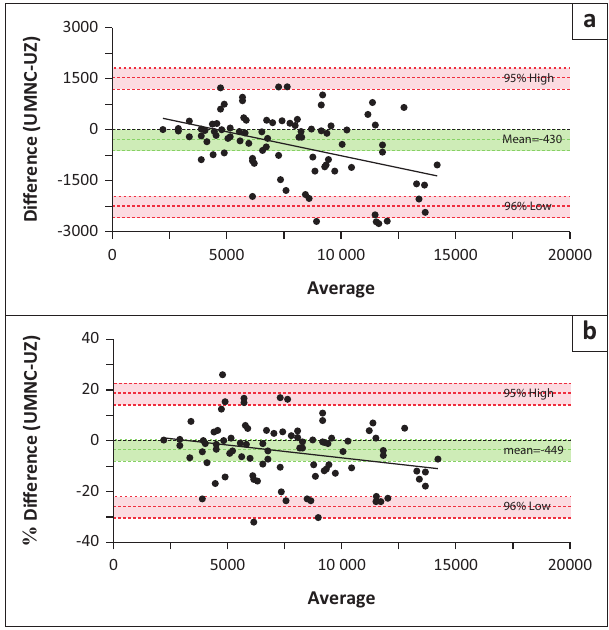
FIGURE 1: Differences in nevirapine concentrations assayed at UNMC-PSL (Omaha, Nebraska, United States, October 2017) and UZ-IPSL (Harare, Zimbabwe, May 2018); (a) Scatter plot ( n = 95 data points). (b) Deming regression plot of 87 data points (outliers excluded). Boxes in (a) indicate UNMC upper limit of quantitation (dashed) and UZ-IPLS upper limit of quantitation (solid lines). UZ-IPSL, University of Zimbabwe International HIV Pharmacology Specialty Laboratory; UNMC-PSL, University of Nebraska Medical Center Pharmacology Specialty